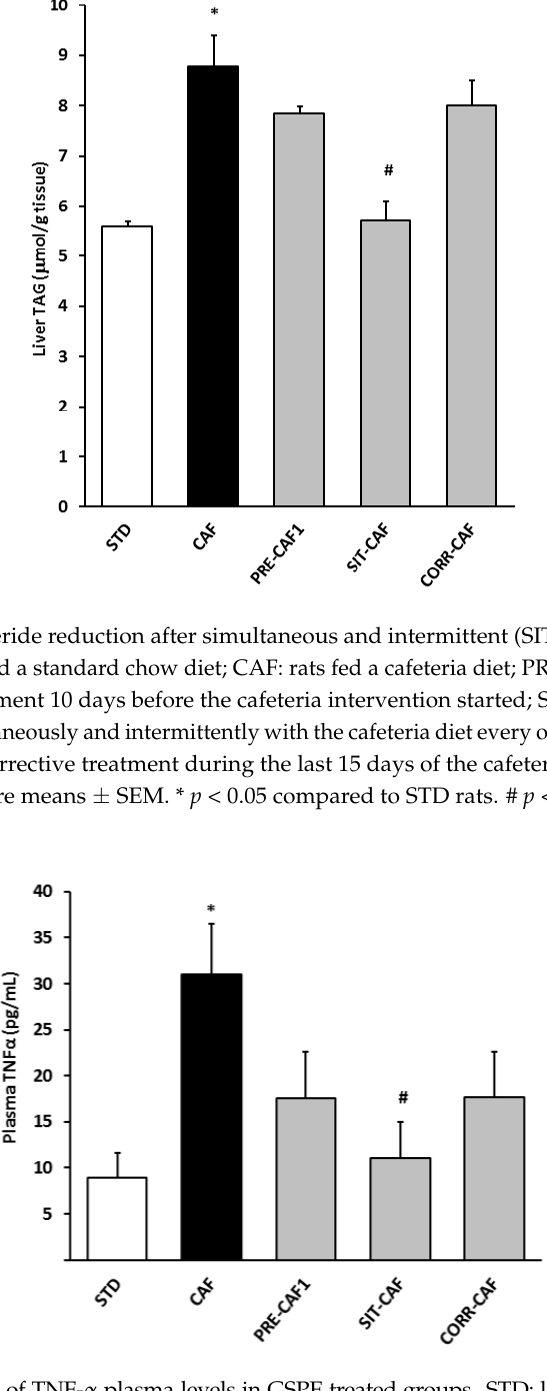
Figure 5. Amelioration of TNF- α plasma levels in GSPE treated groups. STD: lean rats fed a